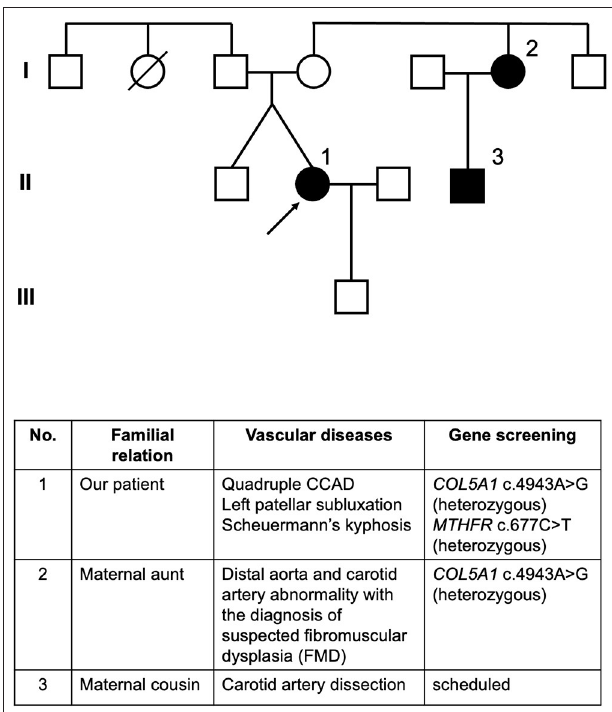
FIGURE 2 | Pedigree of the patient. Individuals affected with arterial lesions are colored in black. Circle 1 indicated by an arrow is our patient. Circle 2 indicates the maternal aunt of our patient who developed abnormalities in the distal aorta and carotid artery with the diagnosis of suspected FMD, whose genetic screening also identified heterozygous COL5A1 c.4943A > G mutation. Square 3 indicates the maternal male cousin of our patient who developed carotid artery dissection and was scheduled for gene